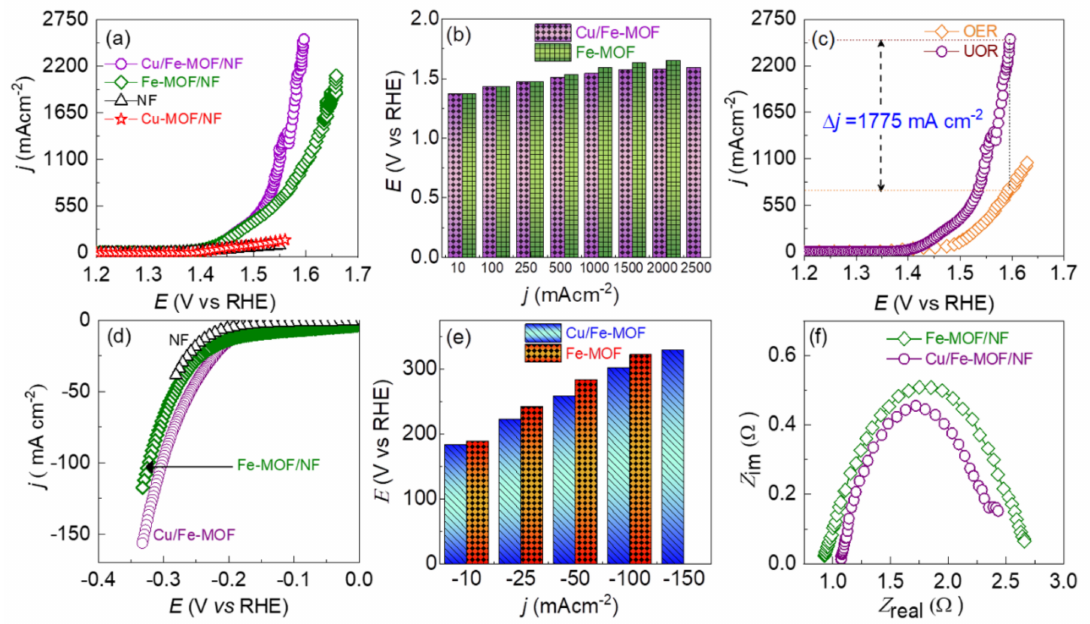
Figure 5. ( a ) Anodic polarization curves in 1.0 M KOH containing 0.33 M urea. ( b ) Corresponding comparison potential vs. UOR current density-based bar graph extracted from the anodic LSV. ( c ) Comparison of the OER and UOR polarization curves for the Cu/Fe-MOF. ( d ) Cathodic polar- ization curves. ( e ) Corresponding comparison potential vs. HER current density-based bar graph extracted from the cathodic LSV curves. ( f ) Nyquist plots from the EIS